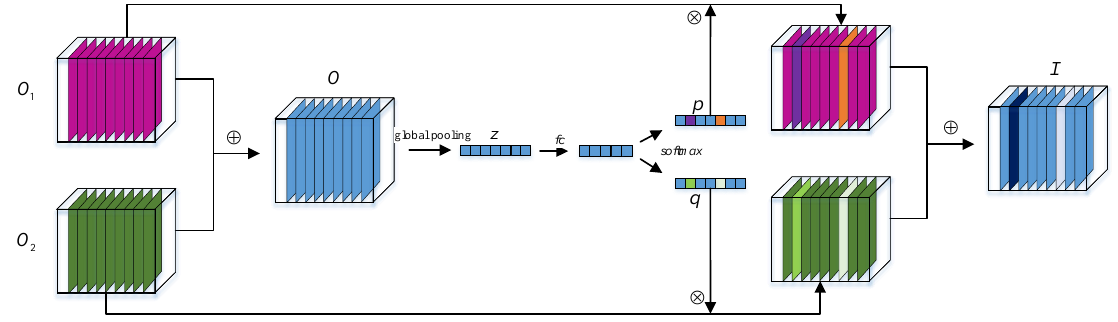
Figure 4. Illustration of multiscale feature-fusion module.